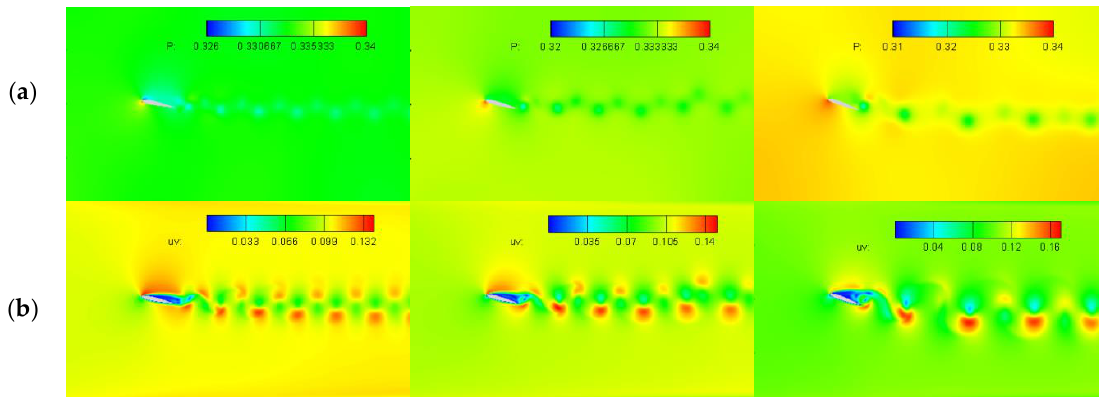
Figure 12. Pressure and velocity clouds at different angles of attack: ( a ) pressure distribution on the upper side; ( b ) lower right side of the foil. The angles of attack are 0°, 4°, and 8° (left to right).